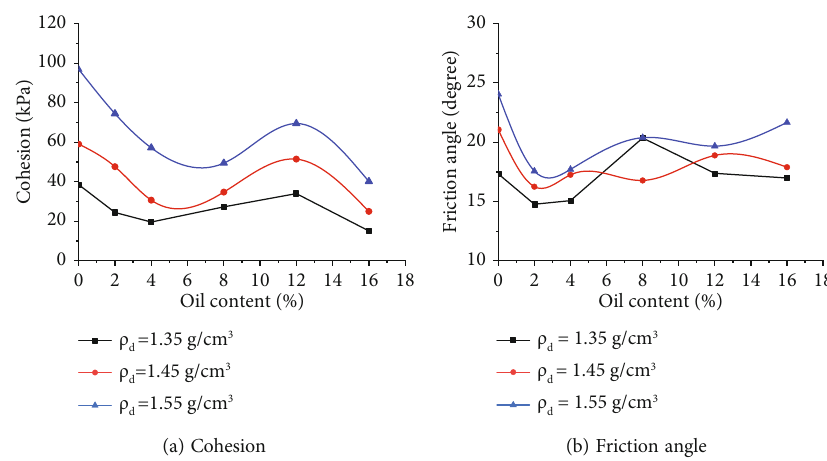
Figure 6: Shear strength characteristics of diesel-contaminated loess under the fi rst mode of oil contamination.